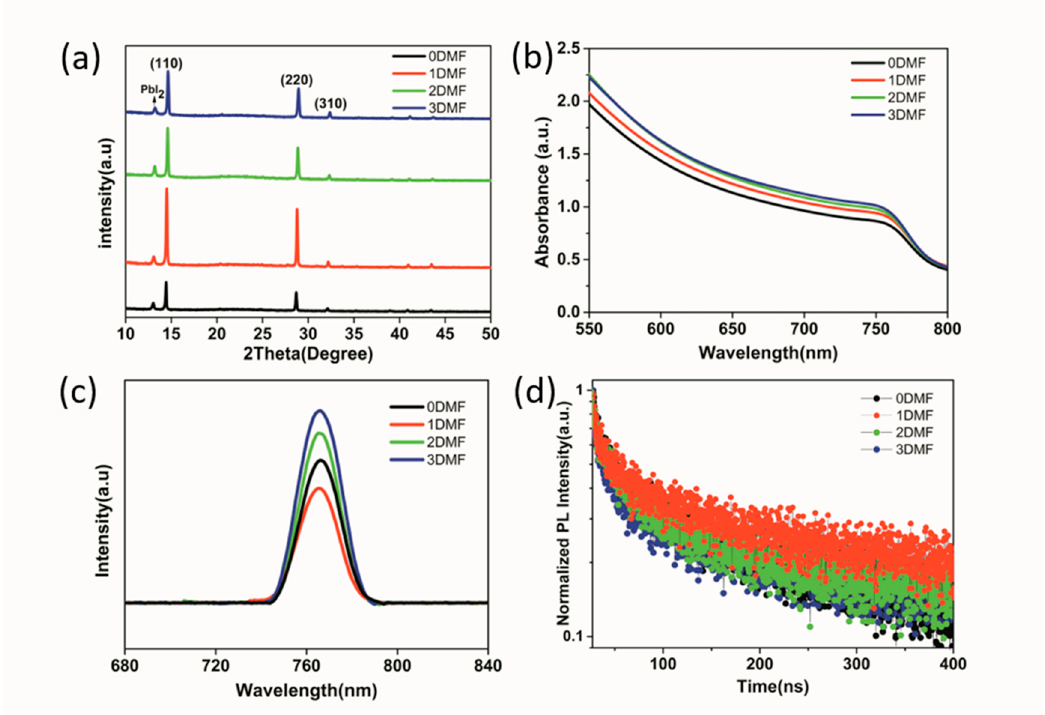
Figure 7. ( a ) XRD spectra of perovskite films on quartz by using different precursors; ( b ) UV − vis absorption spectra of perovskite films; ( c ) Steady-state photoluminescence (PL) spectra of different perovskite films on FTO/TiO2 ( d ) Normalized time-resolved PL (TRPL) spectra of the different perovskite films on glass.